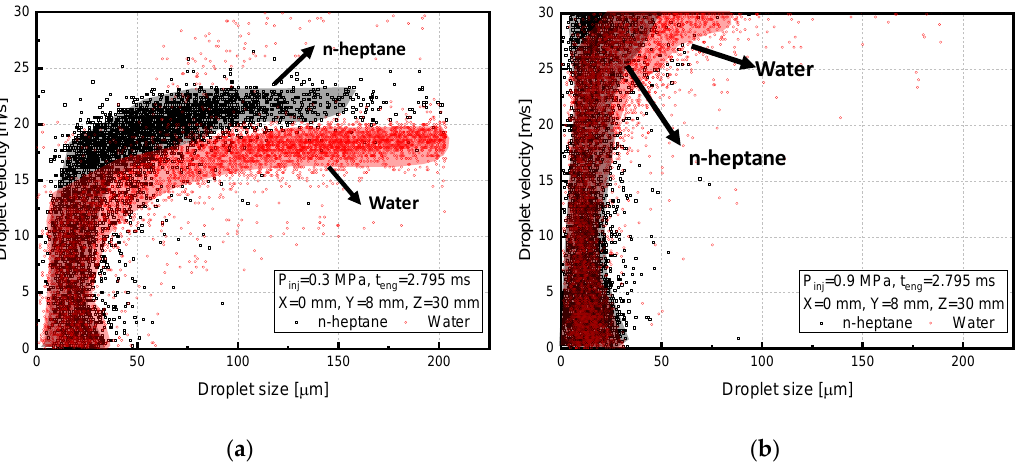
Figure 11. Comparison of distribution correlation of droplet velocity and size of water and n-heptane at ( a ) P inj = 0.3 MPa, ( b ) P inj = 0.9 MPa.